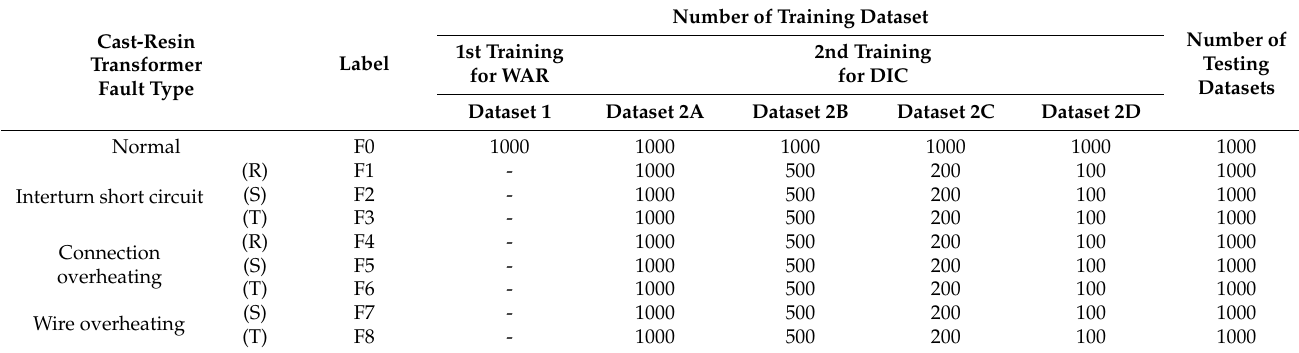
Table 5. The detailed description of the faulty IRT image dataset.